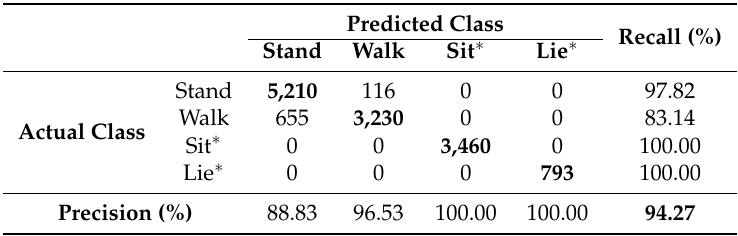
Table 5. Confusion matrix of our CNN+Sharpen approach using lower body OPPORTUNITY dataset. The bold numbers in diagonal indicate correctly classified instances; the bottom right bold number indicates the overall